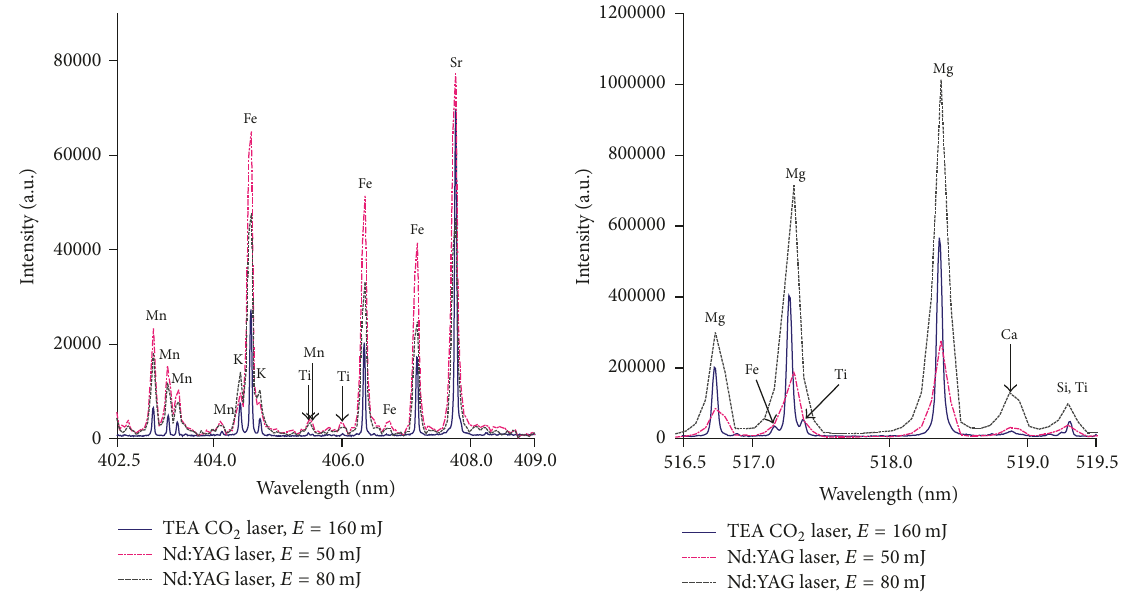
Figure 2: LIBS spectra obtained on the basalt sample with a single TEA CO 2 laser pulse using a nongated detection and with Nd:YAG laser and time-gated detection (delay: 1.27 𝜇 s; integration time gate: 1.1ms). In both cases, the plasma was induced in air at atmospheric pressure.